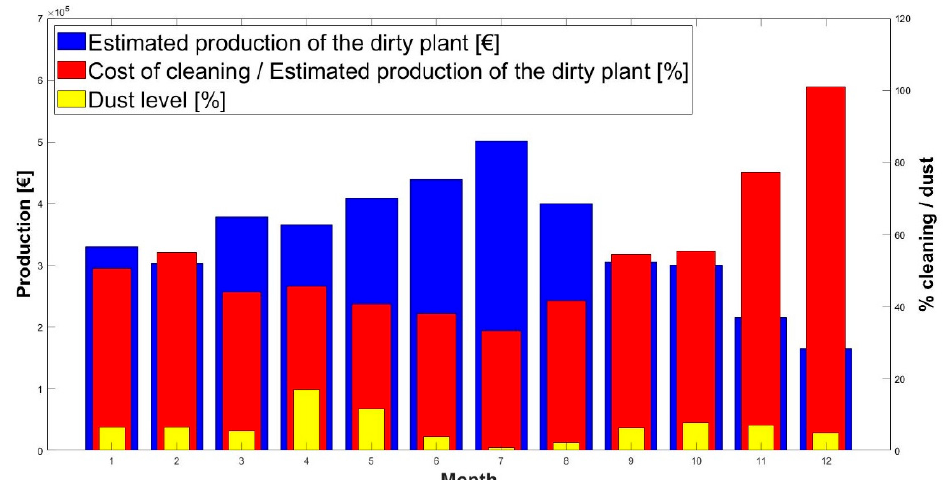
Figure 23. Representation of the minimum percentage of dust required to make the cleaning of the 50 MWp plant profitable.